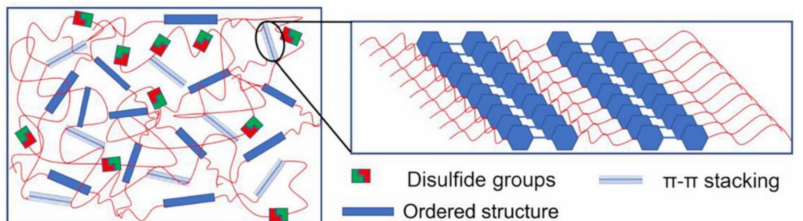
Figure 29. Schematic diagram of the structure of a self-healing and reproducible disulfide-based liquid crystal elastomer. Reproduced from [174] with permission from John Wiley and Sons.